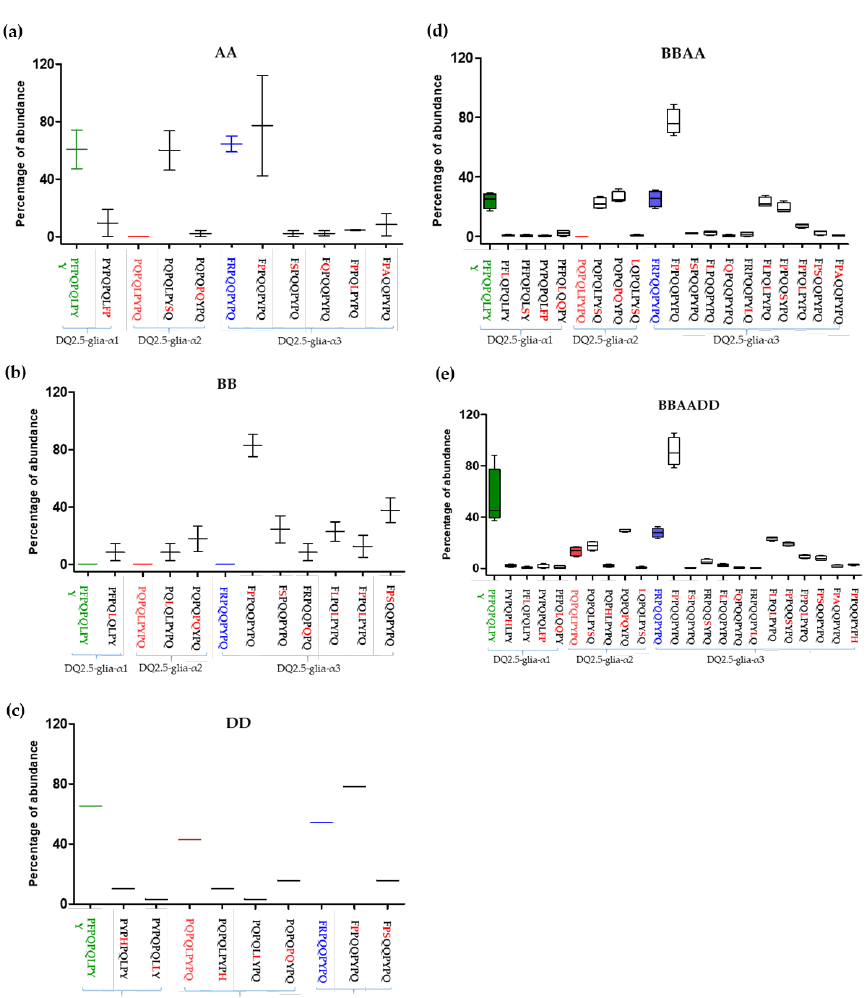
Figure 5. Abundance of epitope variants according to wheat genome type . The epitopes represented showed more than 1% of abundance in each gliadin domain. ( a ) AA genome, ( b ) BB genome, ( c ) DD genome, ( d ) BBAA genome, and ( e ) BBAADD genome. DQ2.5-glia- α1 epitope: green; DQ2.5 -glia- α2 α 1 epitope: green; DQ2.5-glia- α 2 epitope: red; DQ2.5-glia- α3 epitope: blue. genome, ( d ) BBAA genome, and ( e ) BBAADD genome. DQ2.5-glia- epitope: red; DQ2.5-glia- α 3 epitope: